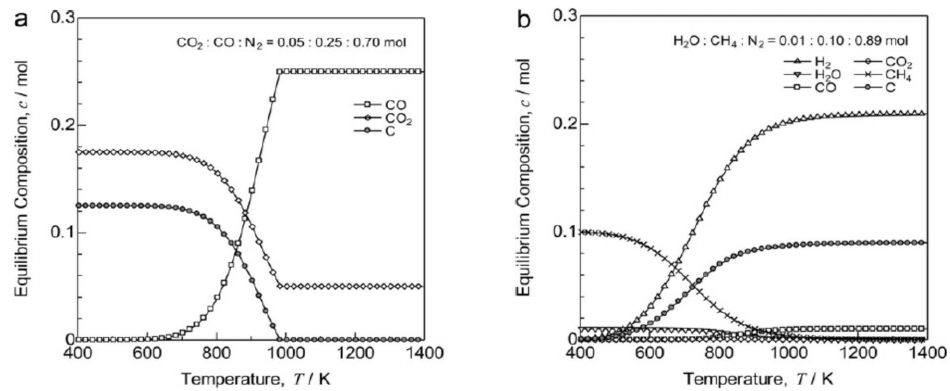
Figure 3. The equilibrium concentration of product for a typical SOFC feed composition